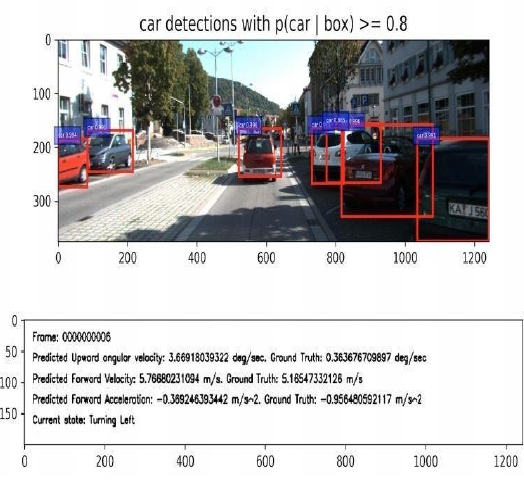
Fig 1 : Visual Results